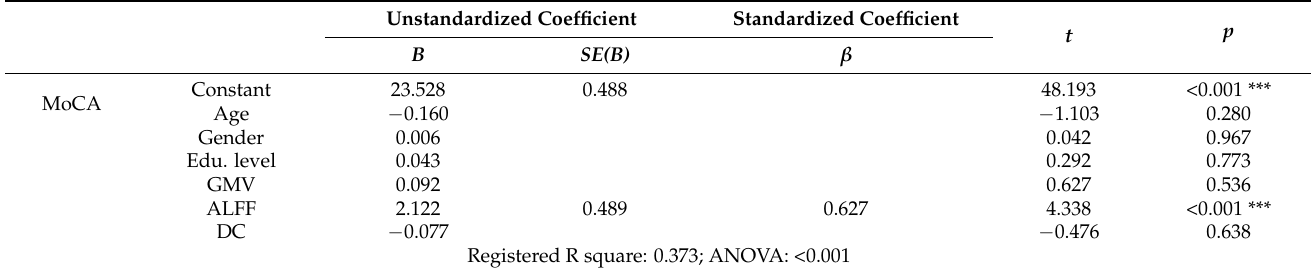
Table 4. Linear regression between MoCA and ALFF, HAMA and DC, and HAMD and